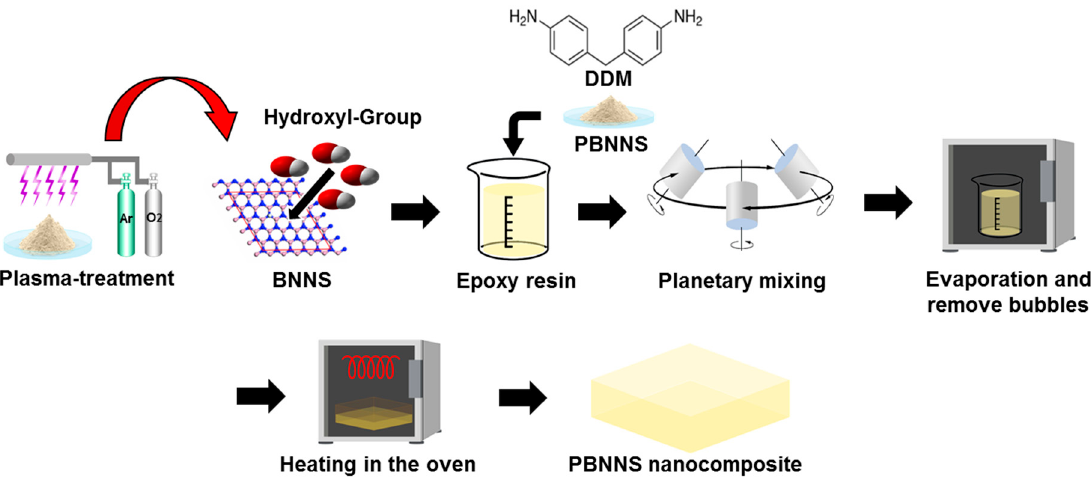
Figure 2. Schematic representation of preparation process on PBNNS nanocomposites.